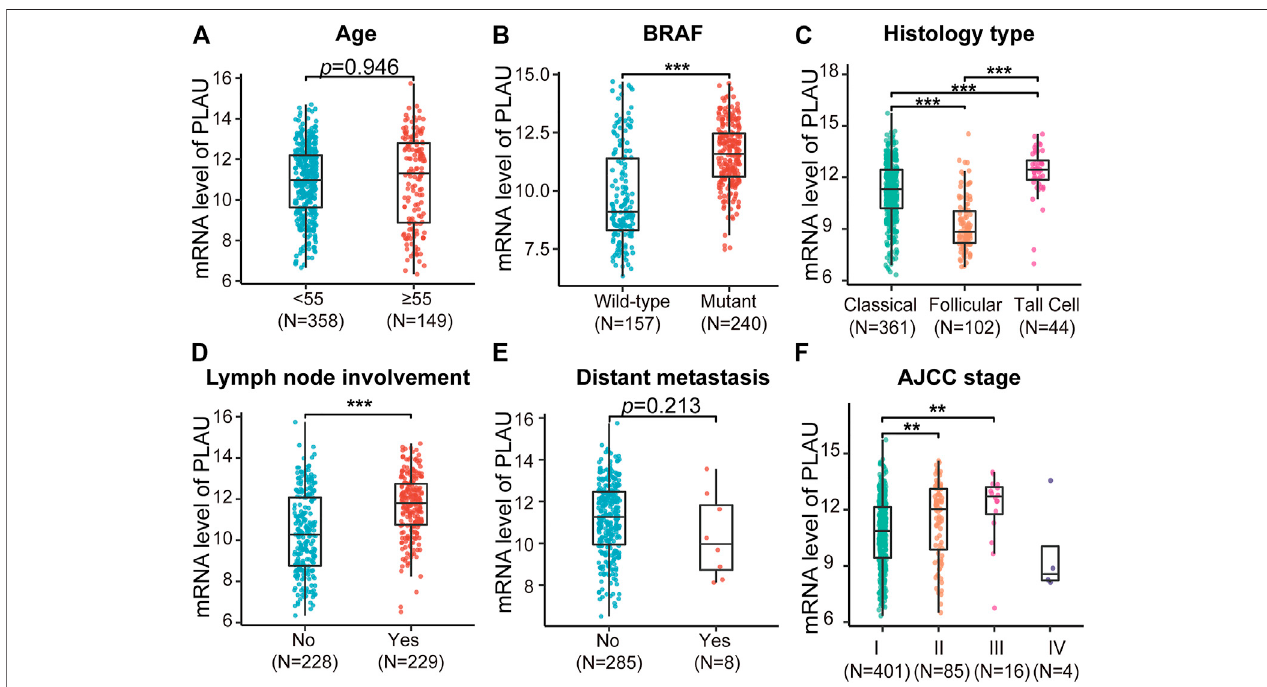
FIGURE4| ComparativeanalysisofthemRNAlevelsofPLAU indifferentTHCAsubtypes. Theexpression dataofPLAUand thematchedclinicalinformationwere downloaded from theTCGA database. ThemRNA level ofPLAU wascompared inTHCA patients with different (A) age, (B) BRAF mutation status, (C) histologicaltype, (D) lymph node metastasis status, (E) distant metastasis status, and (F) stage, Student ’ s t-test, ** p < 0.01, *** p < 0.001.